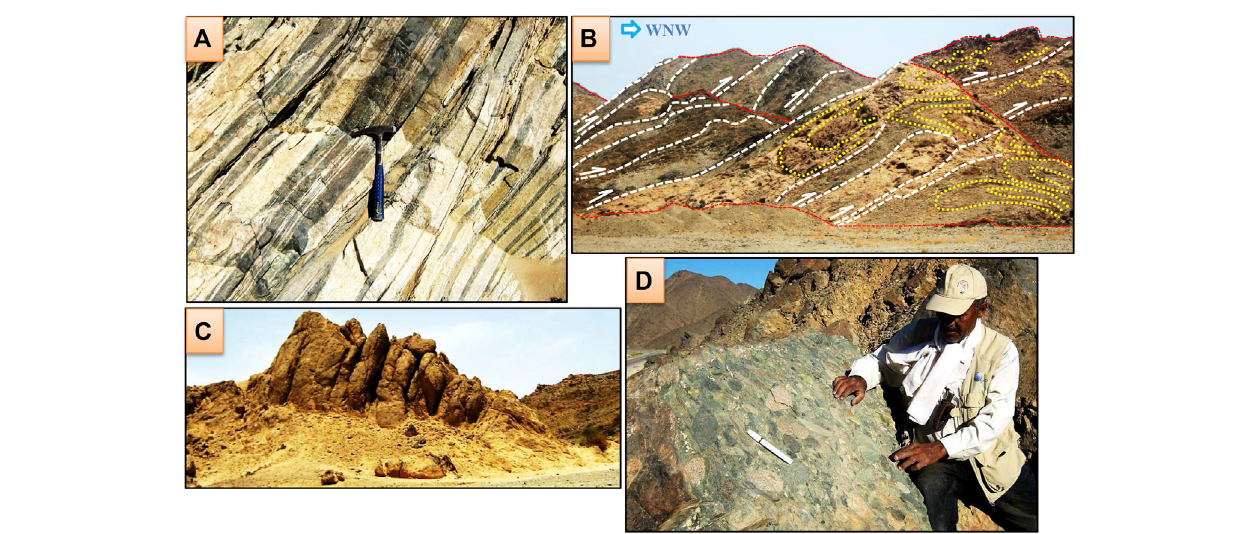
FIGURE 3 | (A) Migmatitic gneisses from the Wadi Kuda (SED). (B) Massive serpentinite from the Ghadir area with propagated thrusts (white lines) and thrust- related folds (yellow lines). Red lines de fi ne the summits of serpentinite ridges. (C) Syn-tectonic granites from the Abu Dabbab area. (D) Polymictic conglomerates from the post-amalgamation volcano sedimentary sequence of Wadi